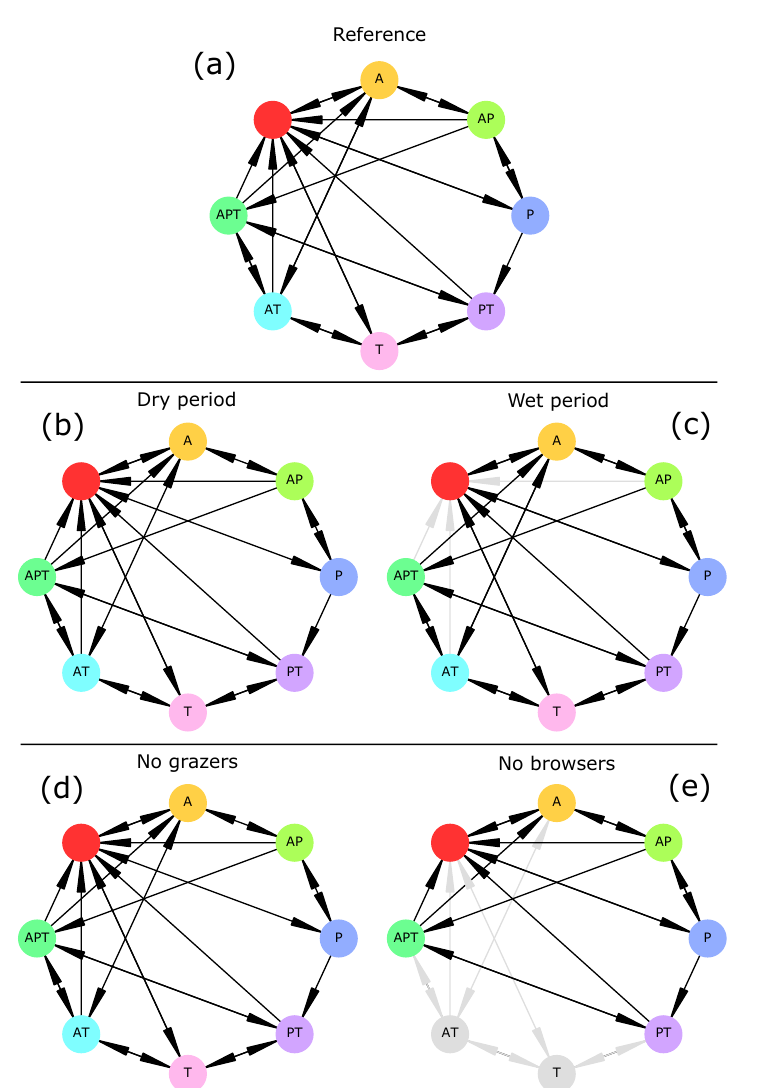
Figure 4. Socio-economic transitions for each scenario. Socio-economic summary graphs for ( a ) the reference scenario, ( b ) the “dry period”, ( c ) the “wet period”, ( d ) “no grazers”, and ( e ) “no browsers”. Node labels indicate socio-economic profiles, i.e., combinations of socio-economic activities A, P, and T, with A: Agriculture; P: Pastoralism, and T: Tourism. Non-gray node colors are arbitrary and correspond to socio-economic profiles. Grayed out nodes and edges are absent from the graph and highlight differences relative to the reference